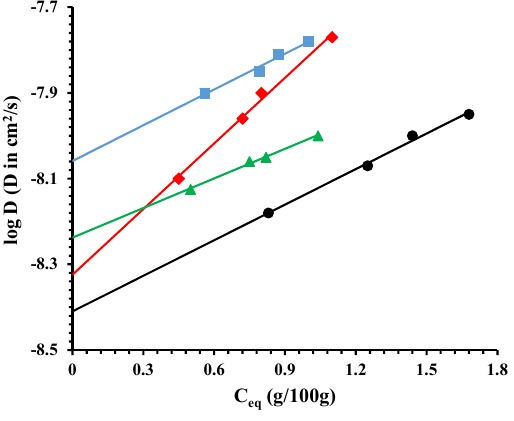
Figure 6. Log diffusion for: PCL/10%HNTs ‐ lysozyme ( ● ), a sample drawn at λ = 3 ( ), a sample drawn at λ = 4 ( ▲ ), and a sample drawn at λ = 5 ( ■ ).